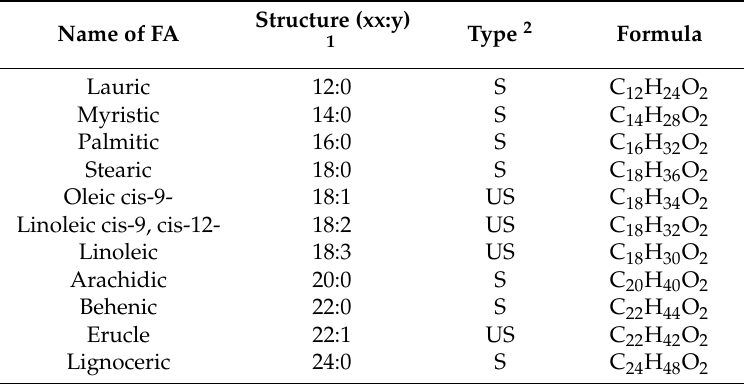
Table 1. Chemical structures of common FA